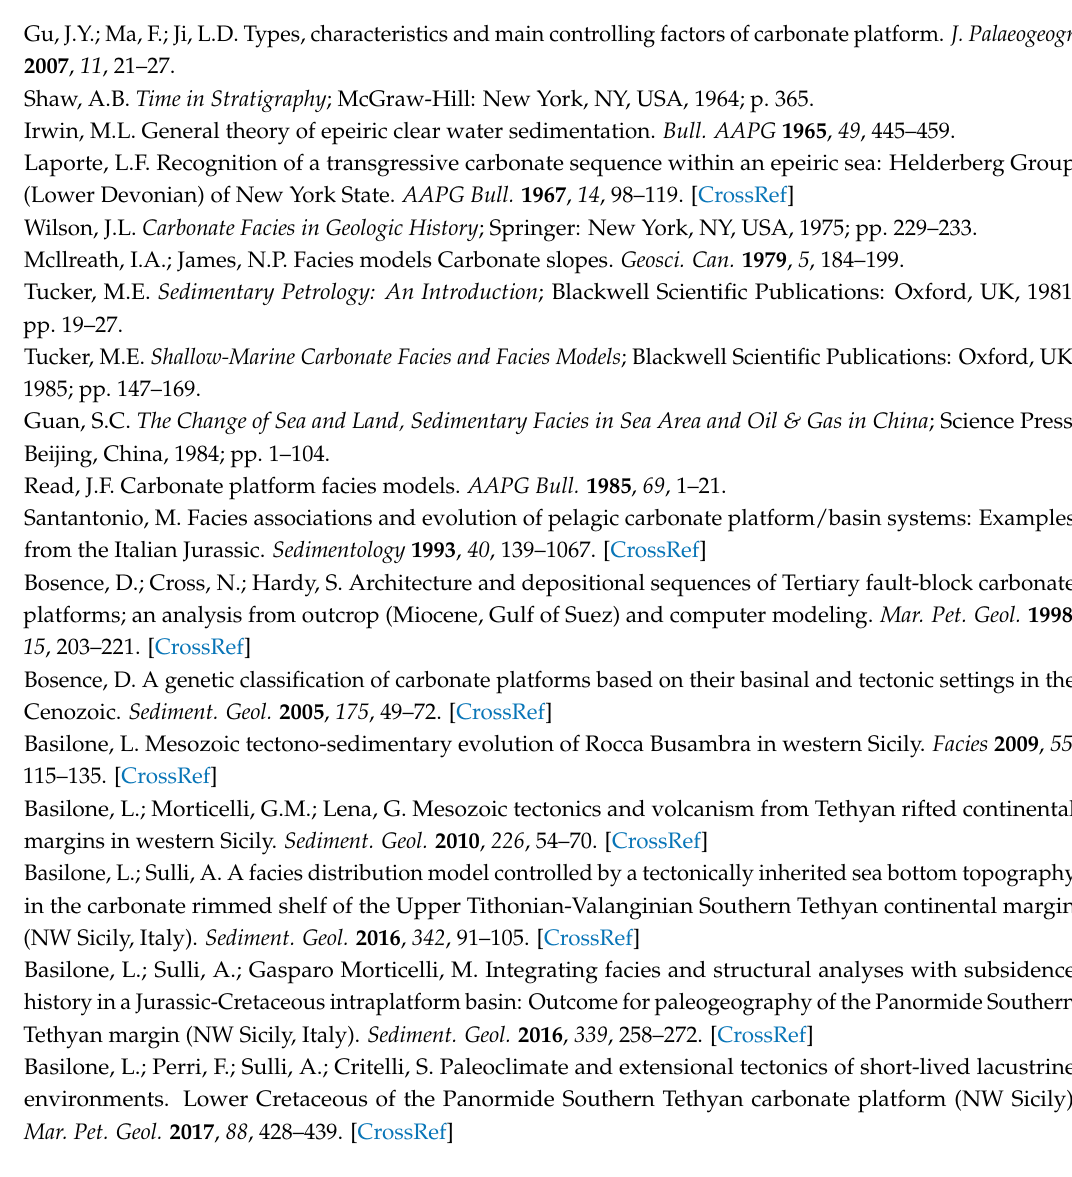
Table S1: Results of porosity and permeability from different microfacies of the front gently-inclined ramp in Amu Darya Basin, Table S2: XRD analytical results of the front gently-inclined ramp in Amu Darya Basin. Acknowledgments: The support of The National Natural Science Foundation of China (project 41572097), and National Major Science and Technology specific project of China